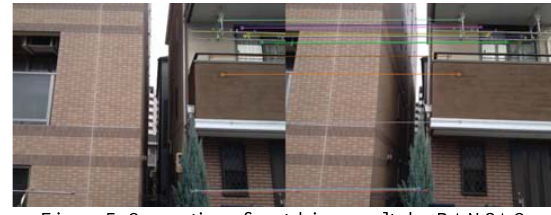
Figure 4. Incorrect matching by SURF